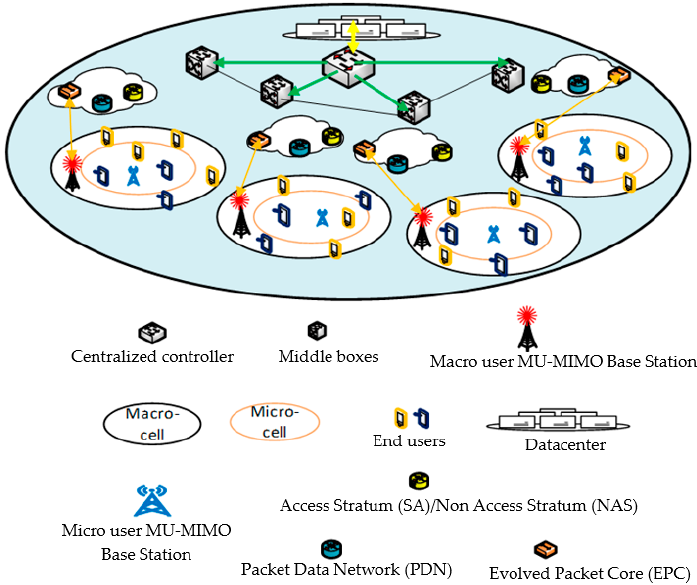
Figure 1. A potential high capacity 5G network architecture.